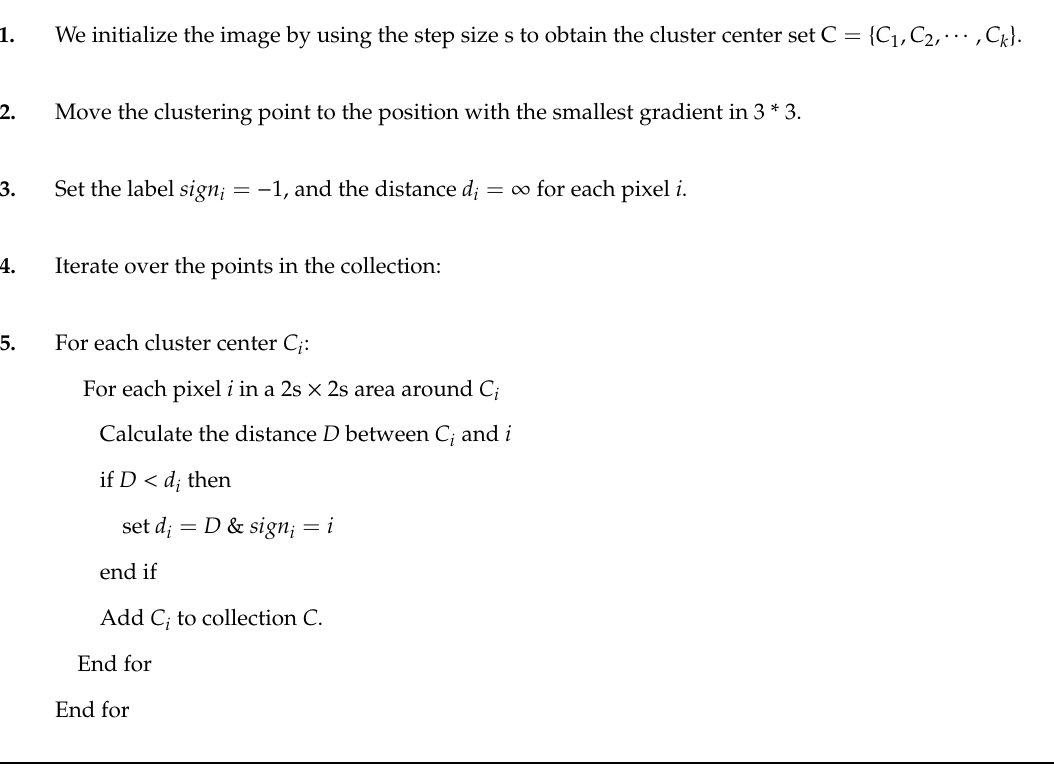
Figure 5. A merged graph when different criteria are used. The values of ( a – c ) represent the results of criteria 1, 2, and 3. In terms of detail, the third image works better. Therefore, criterion 3 was chosen as the consolidation criteria. Algorithm 1. Superpixel region merging